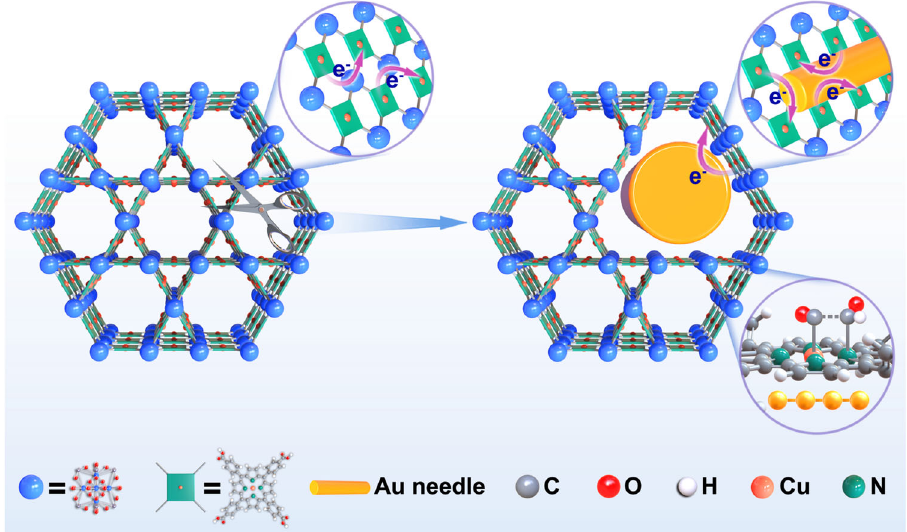
Fig. 1 Schematic illustration of the catalytic mechanism. Impregnation of Au nanoneedles into PCN-222(Cu) with cleaved ligand-node linkage to alter the charge conduction path and steer the CO 2 RR